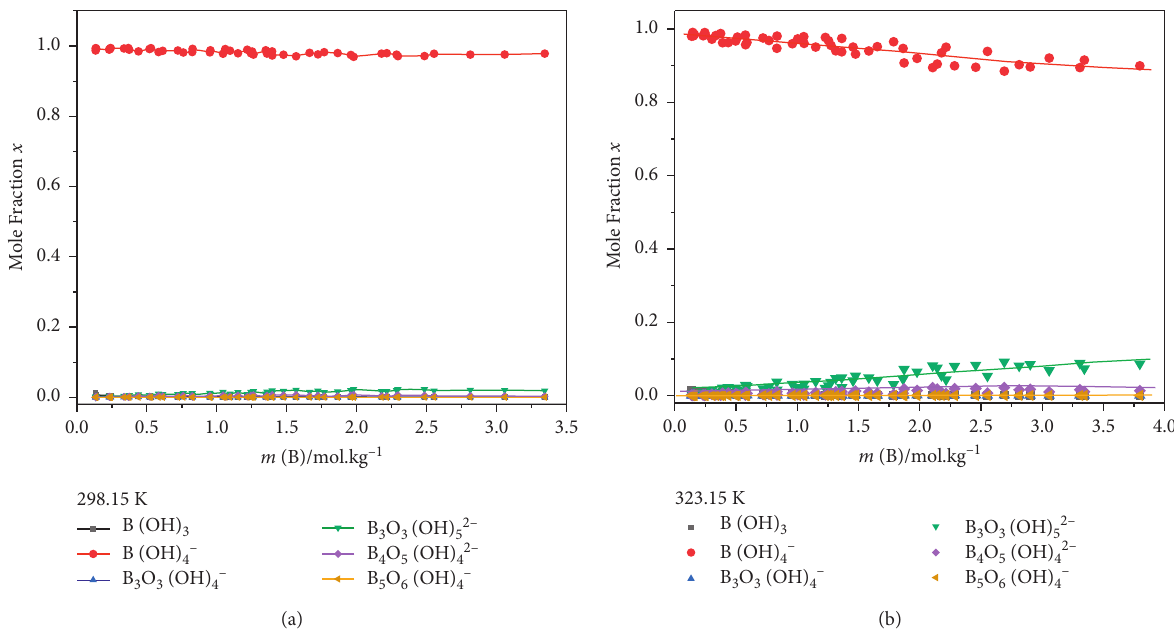
Figure 4: Boron species distribution in mixed aqueous solution of Na B 3 O 3 (OH) 4 ‒ ; , B 3 O 3 (OH) 52 ‒ ; , B 4 O 5 (OH) 42 ‒ ; B 5 O 6 (OH) 4 ‒